Question: What caption would you write for this figure?
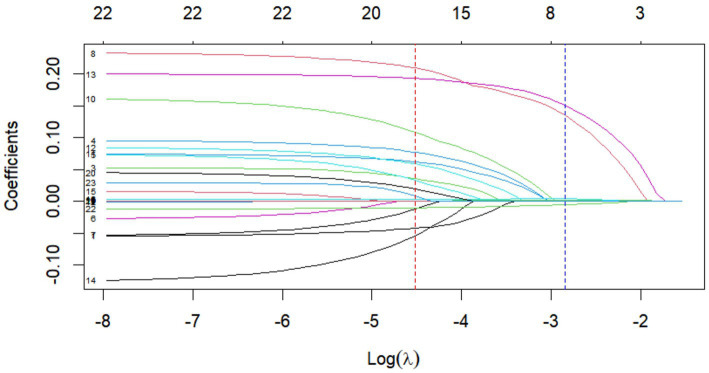
Answer: LASSO regression coefficient path plot.